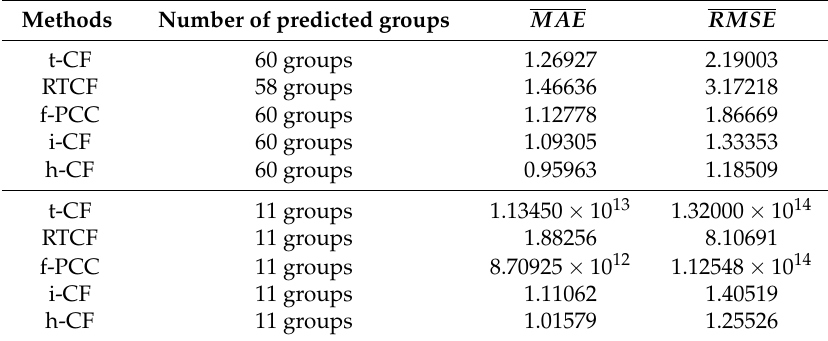
Table 8. Comparison between five methods.